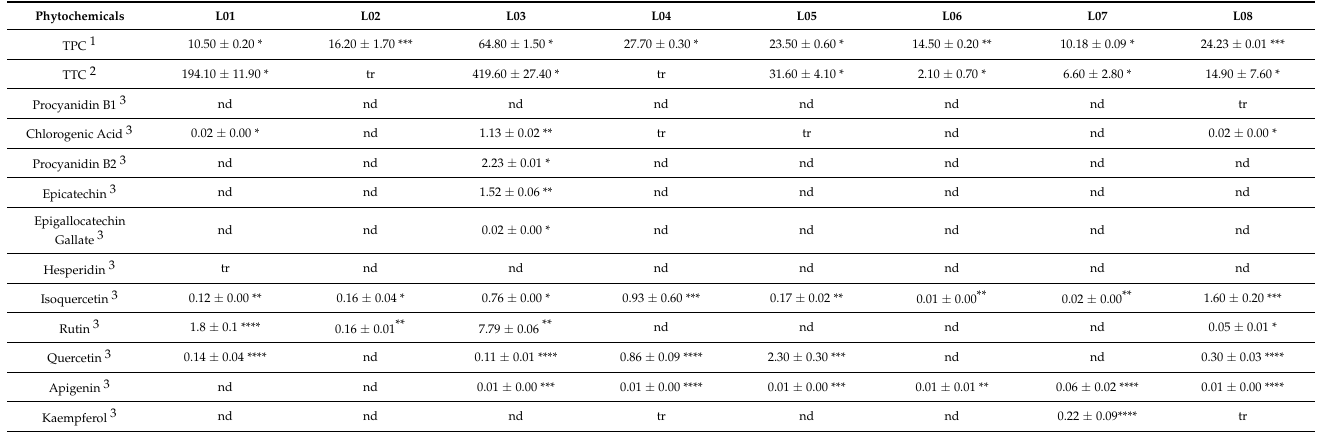
Table 2. Polyphenolic composition, total phenolic (TPC) and tannin (TTC) contents of samples studied.